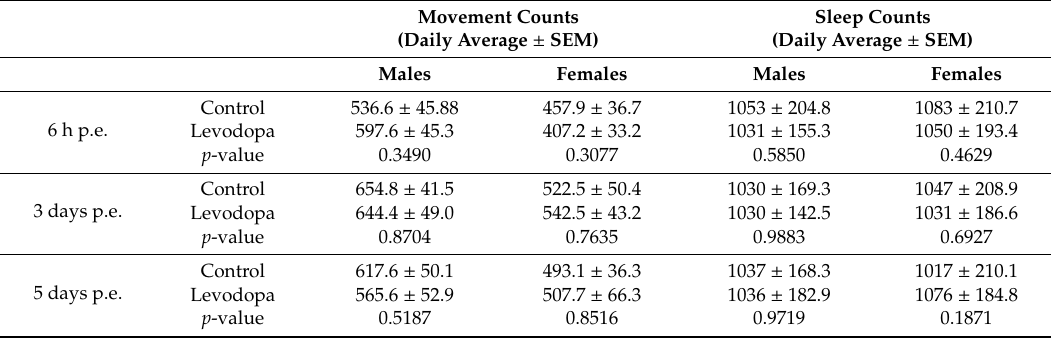
Table 1. Dopaminergic administration does not influence general locomotion. Levodopa treatment